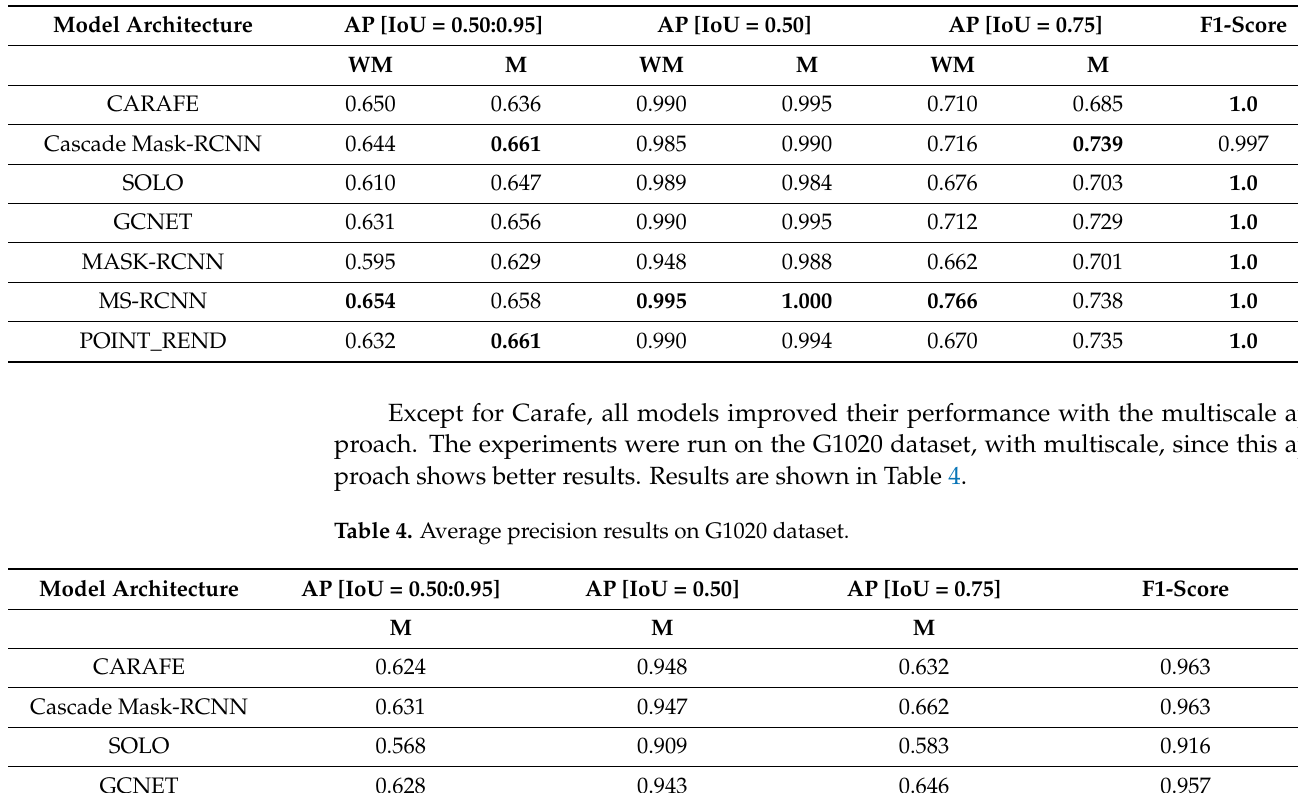
Table 3. Average precision results on full Refuge dataset.